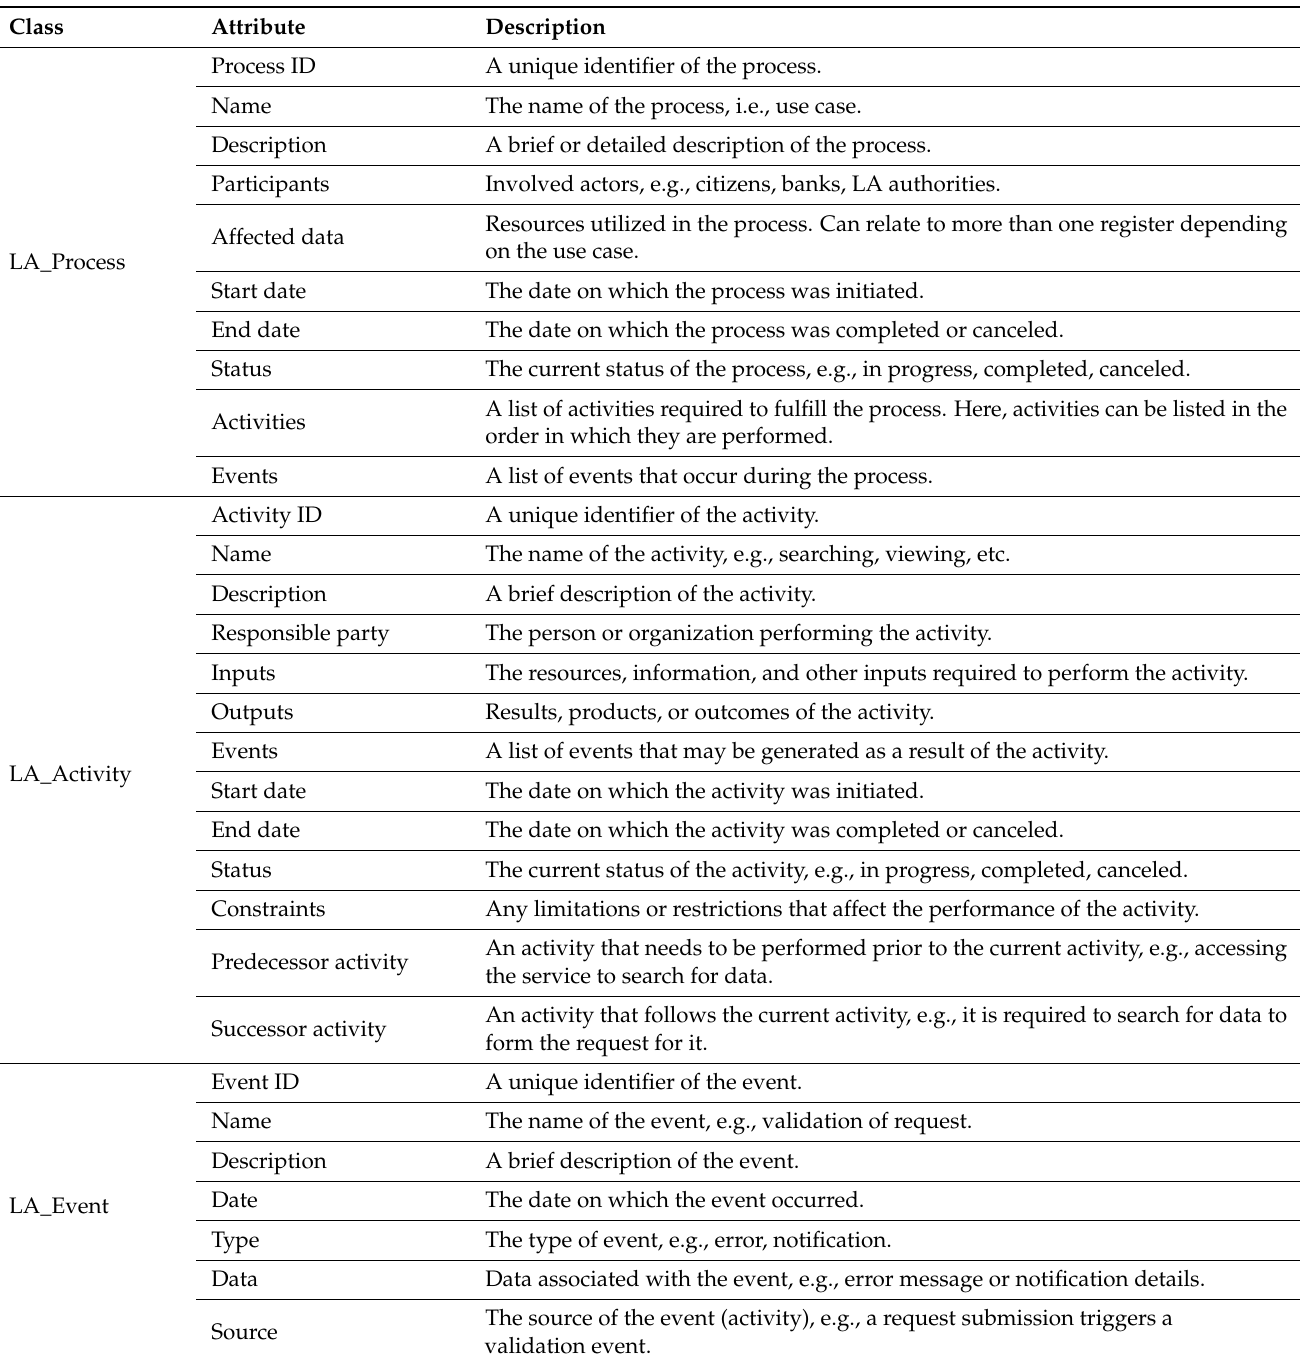
Table 4. Generic attributes of the classes LA_Process, LA_Activity, and LA_Event. Source: Own